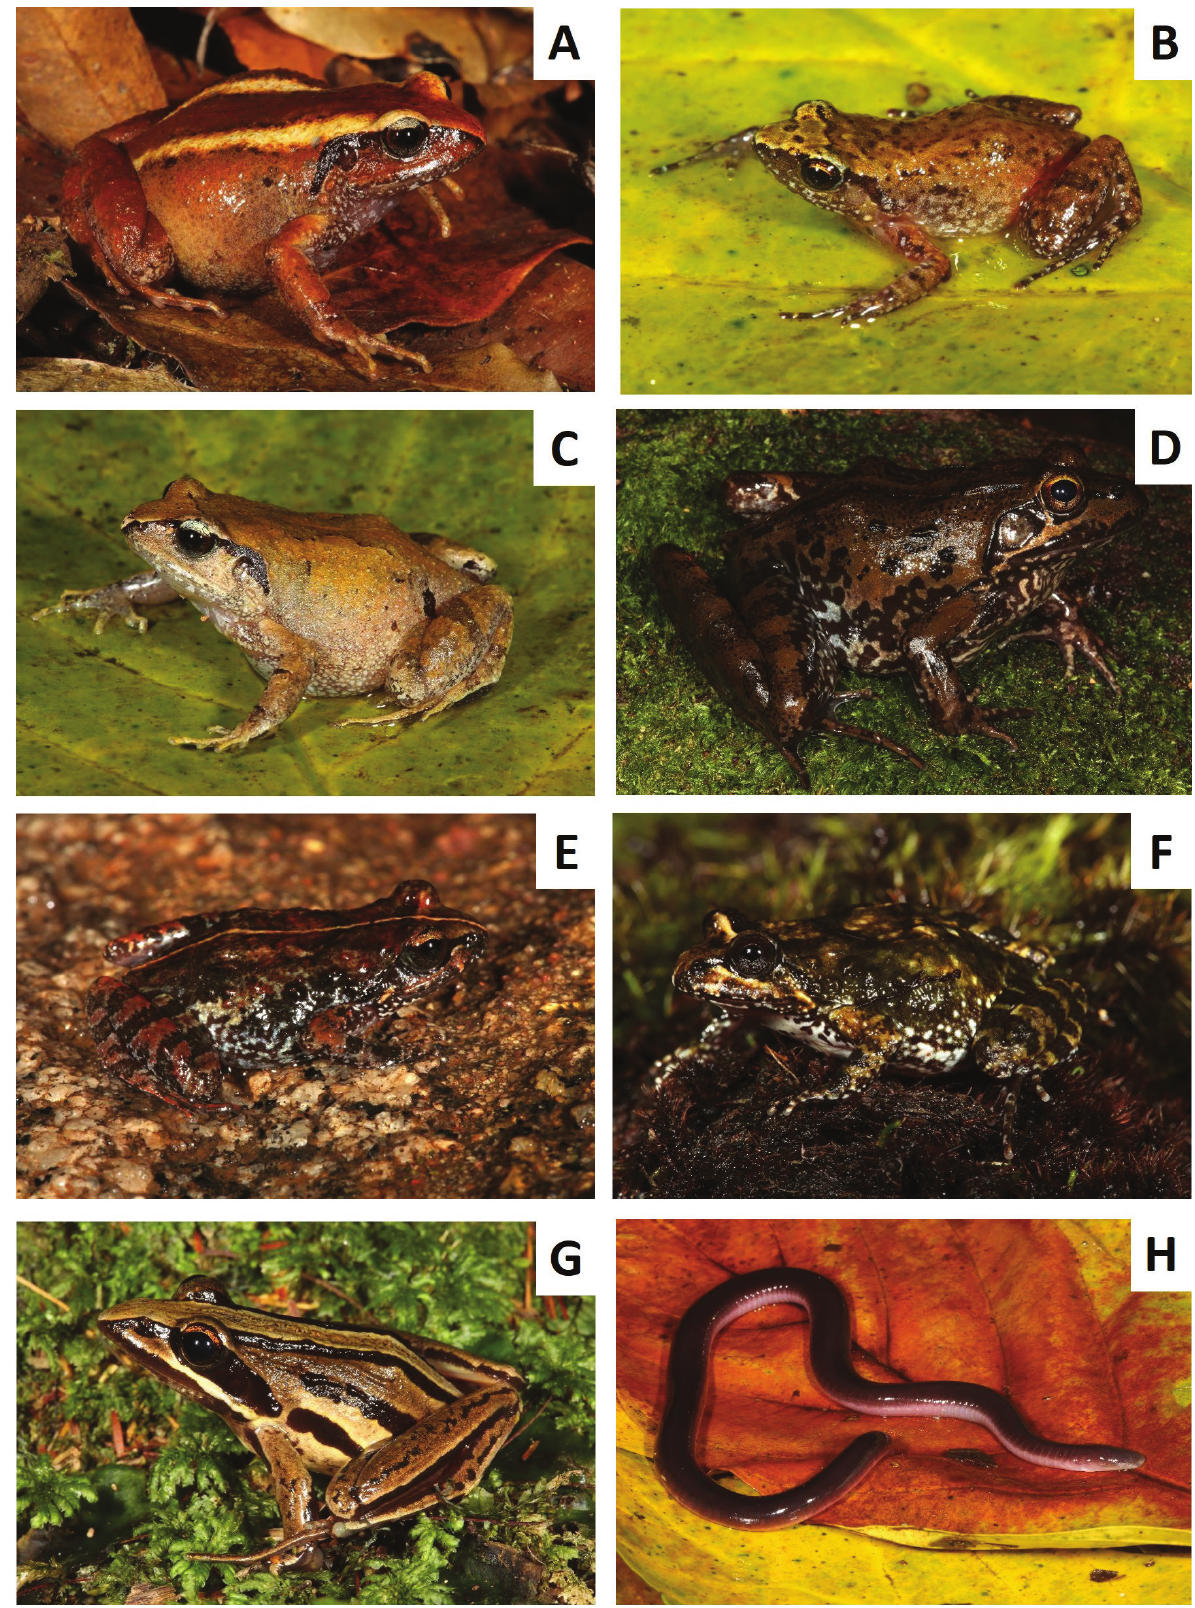
Figure 3. A selection of amphibians from northern Mozambique inselbergs. A – Arthroleptis francei (Mt. Namuli, PEM A11303), B – Arthroleptis xenodactyloides (Mt. Mabu), C – Arthroleptis stenodactylus (Mt. Mabu), D – Amietia delalandii (Mt. Namuli, PEM A11319), E – Nothophryne cf. broadleyi (Mt. M’pàluwé, PEM A11370), F – Nothophryne cf. broadleyi (Mt. Namuli), G – Strongylopus cf. fuelleborni (Mt. Mabu, PEM A11184), H – Scolecomorphus cf. kirkii (Mt. Mabu, PEM